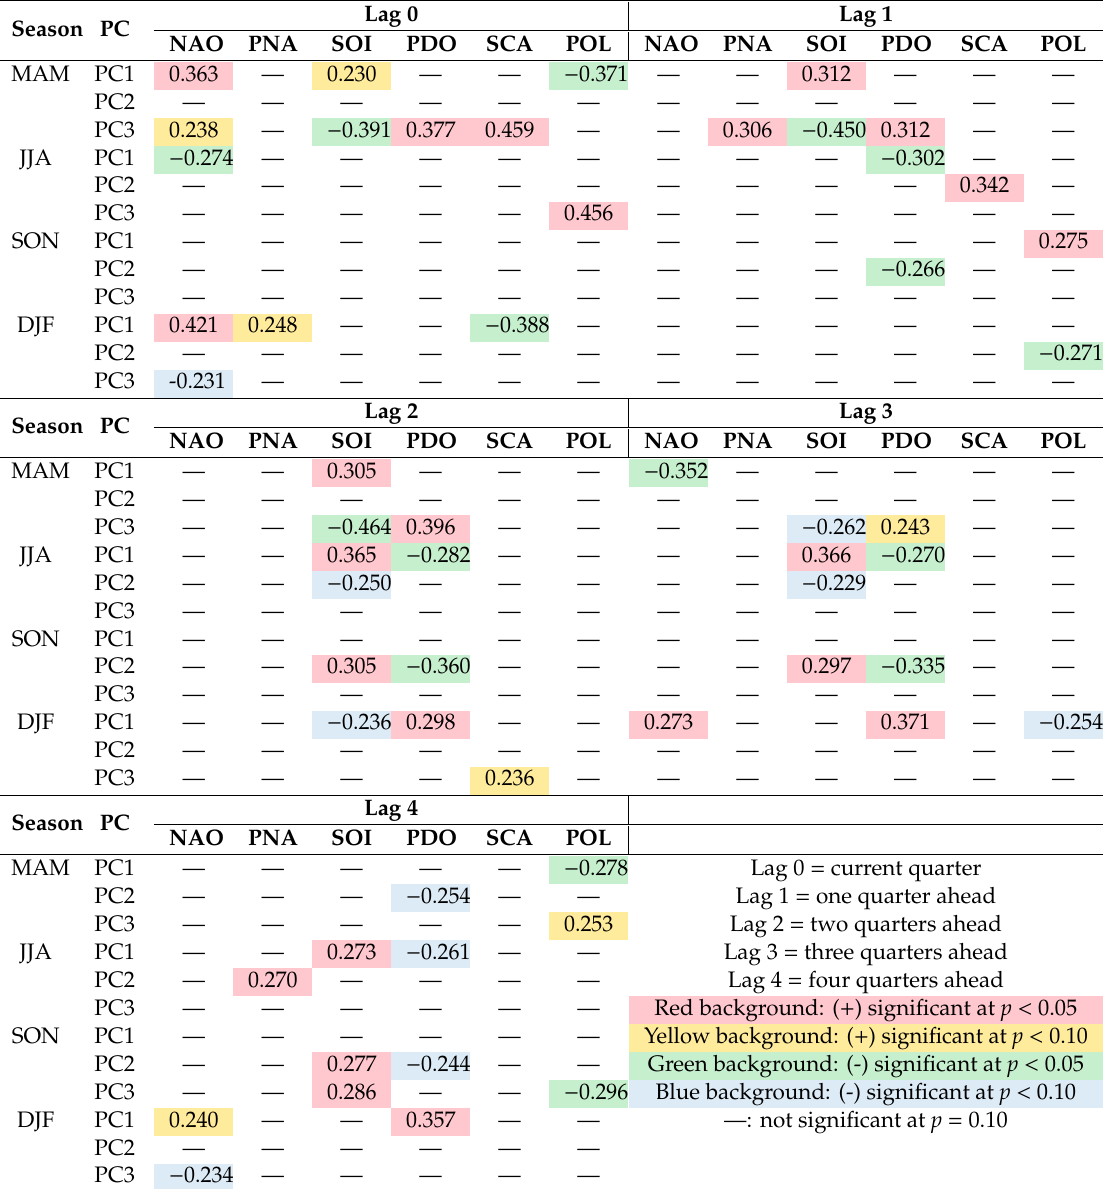
Table 2. Spearman rank correlation between climate indices and leading